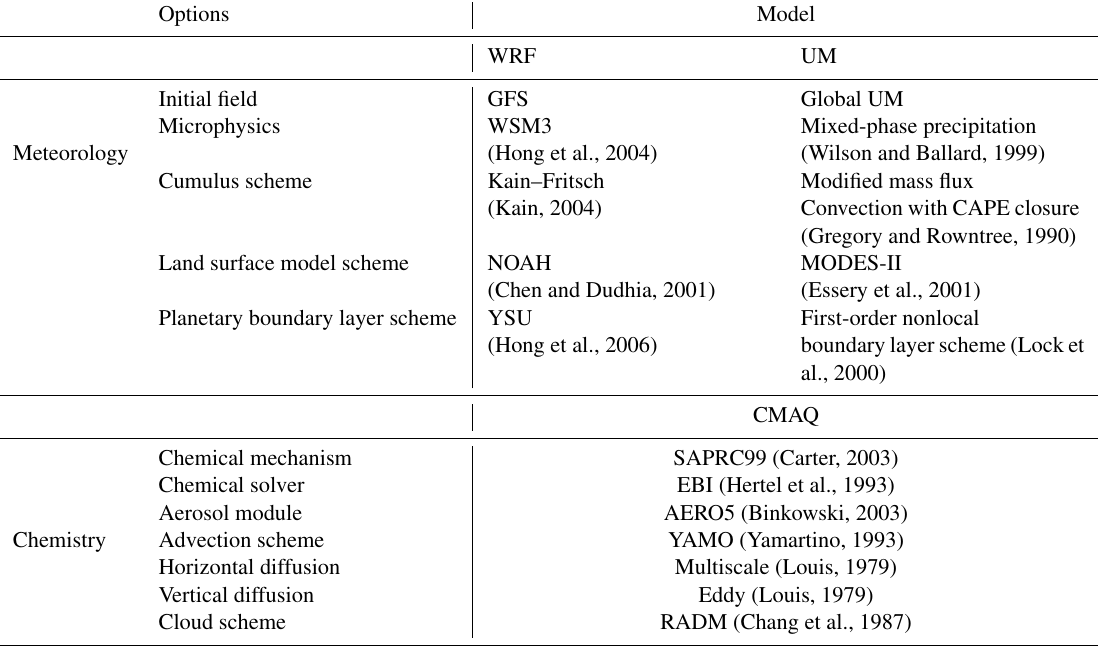
Table 2. Physical options for meteorological and chemical